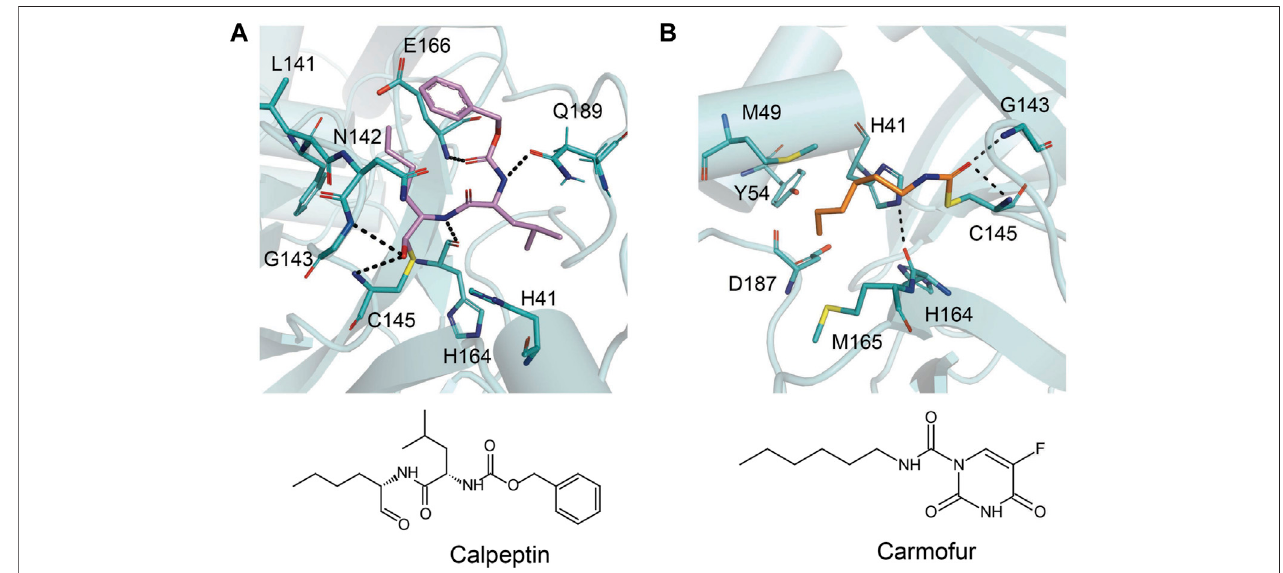
FIGURE13| Close-upviewoftheinteractionsbetweenSARS-CoV-2Mprowithcalpeptinandcarmofur.Close-upviewofinteractionbetweenSARS-CoV-2Mpro and inhibitors in crystal structures. Mpro is shown as cartoon representation, with residues involved in the interaction shown as sticks. Inhibitors are shown as sticks. Hydrogen bonds were labeled with dashed lines. (A) Calpeptin (PDB: 7AKU), violet. (B) Carmofur (PDB: 7BUY),